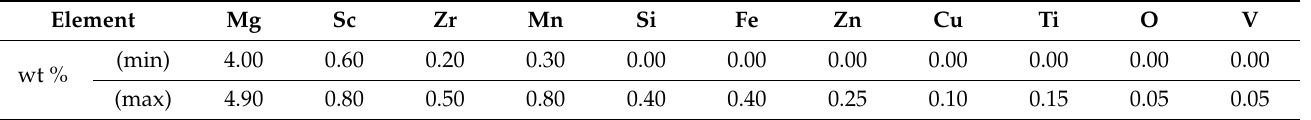
Table 2. Chemical composition of